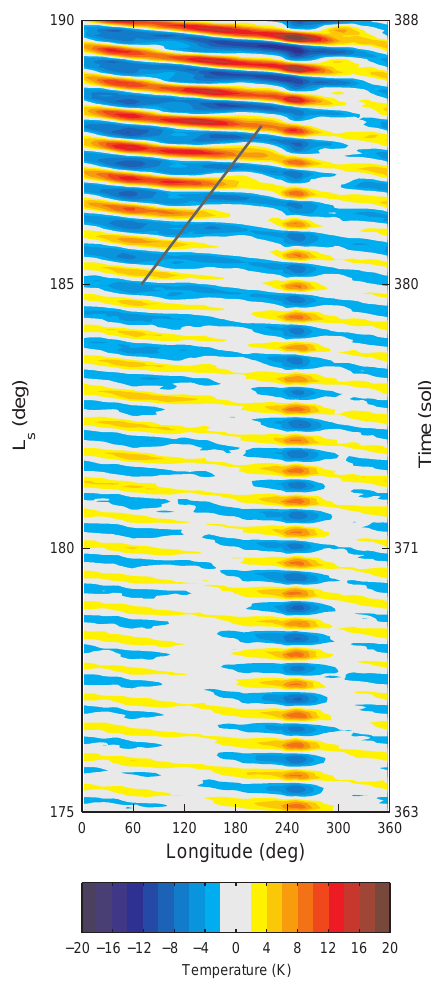
Fig. 6. Hovm¨oller diagram of temperature anomalies at 200Pa in a latitudinal band between 39 ◦ S and the equator in a physical space reconstruction considering every EOF. The eastward propagating disturbance is highlighted by the oblique black